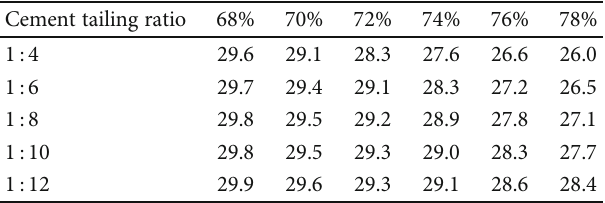
Figure 2: The test process of the slump and expansion degree. Table 4: Slump test results of total tailing mixed slurry (unit: cm). Cement tailing ratio